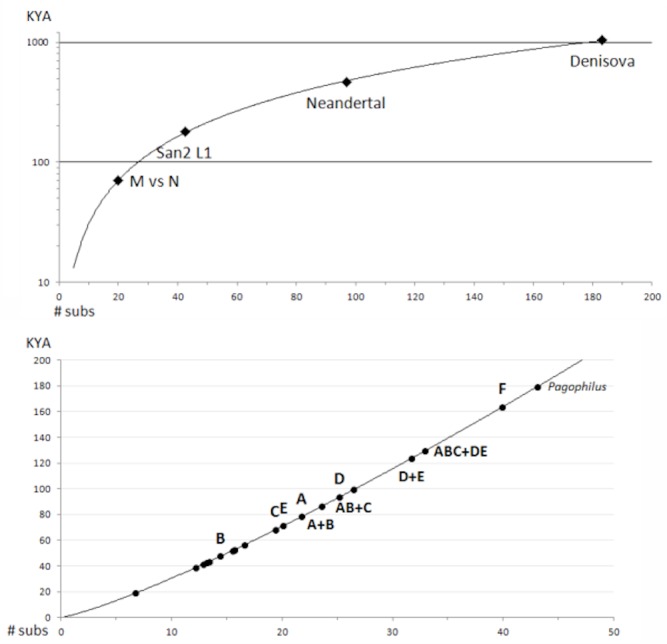
Calibration of intra-specific divergences among Harp Seal clades.(a) ML clock-corrected estimates of the molecular distances to the MRCA for four hominines with established divergence dates < 1 MYA follow a power curve relationship T = 1.886 x (d)1.21 (r2 = 0.9983), where T = KYA and d = linearized ML substitution rates (semi-log plot). Sources of homine mtDNA genomes are given in Methods: San2 is in the L1 haplogroup that is the basal divergence from other extant Homo [1], M vs N is the divergence between haplotypes in the U and A haplogroups, respectively [9]. (b) Dates of the MRCA of the major intra-specific Pagophilus clades estimated from the same power curve (linear plot).